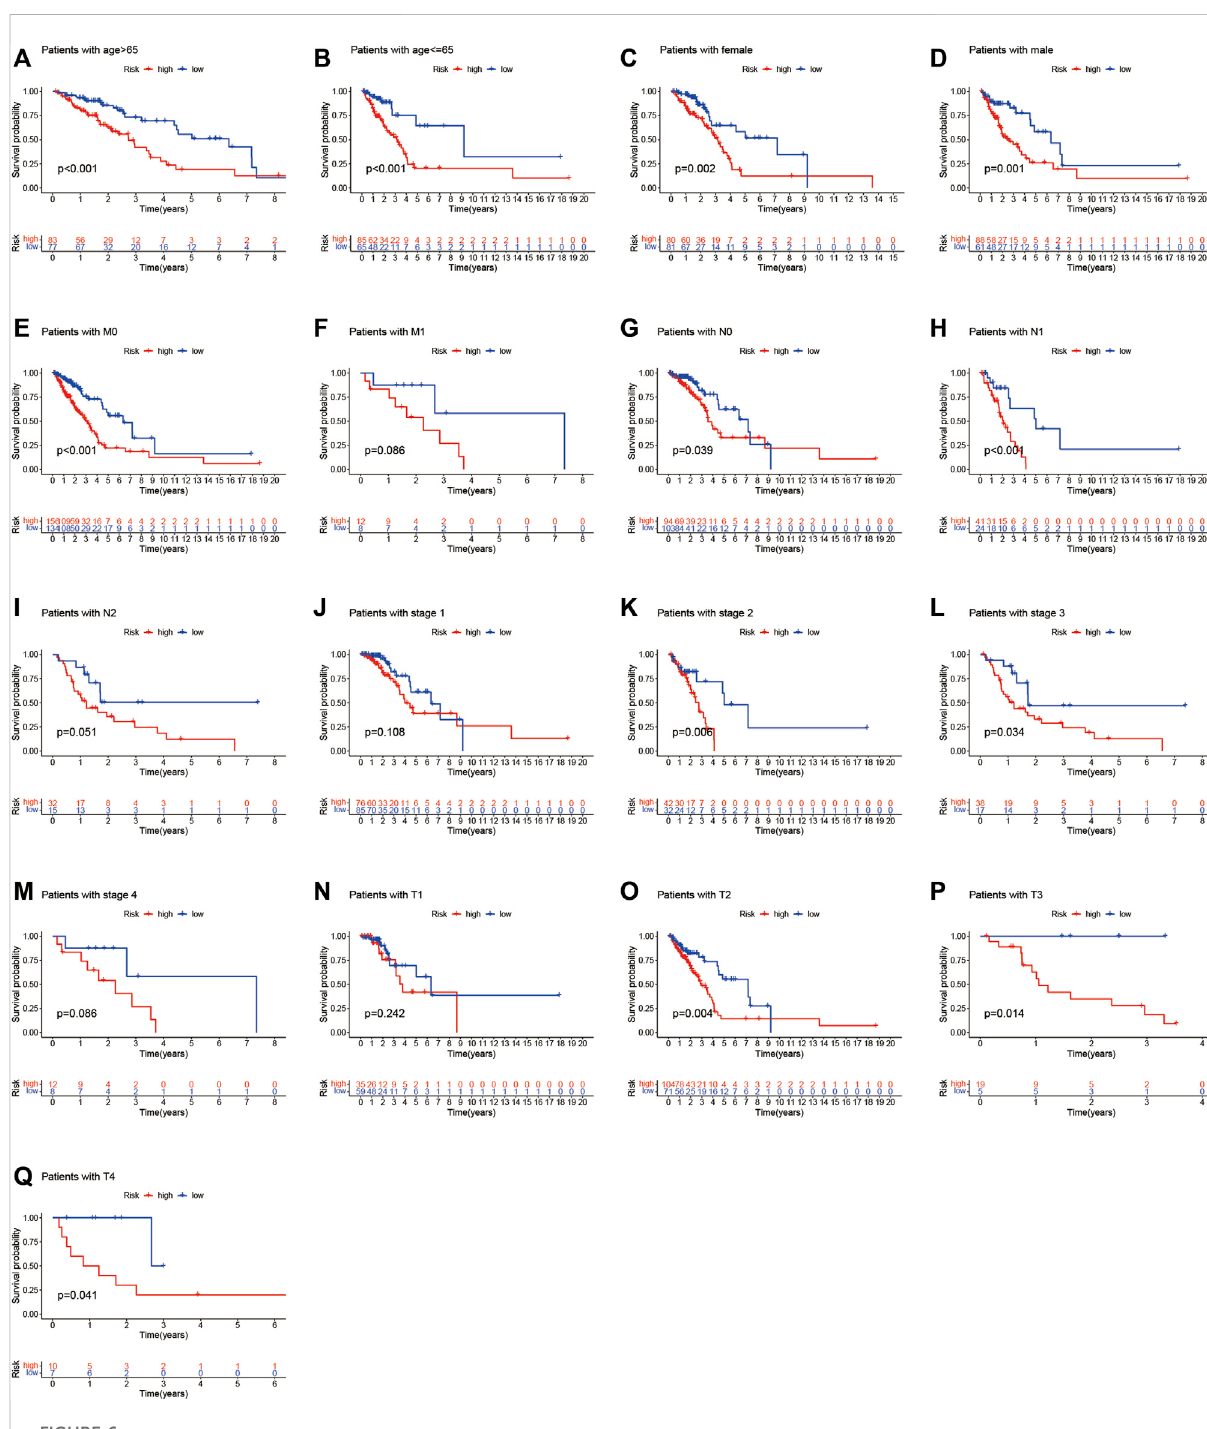
FIGURE 6 Kaplan – Meier survival curves for low- and high-risk groups classi fi ed based on clinicopathological variables. (A,B) Age; (C,D) Sex; (E,F) M stage; (G – I) N stage; (J – M) Overall stage; (N – Q) T stage. T, tumor; N, lymph node metastasis; M, distant